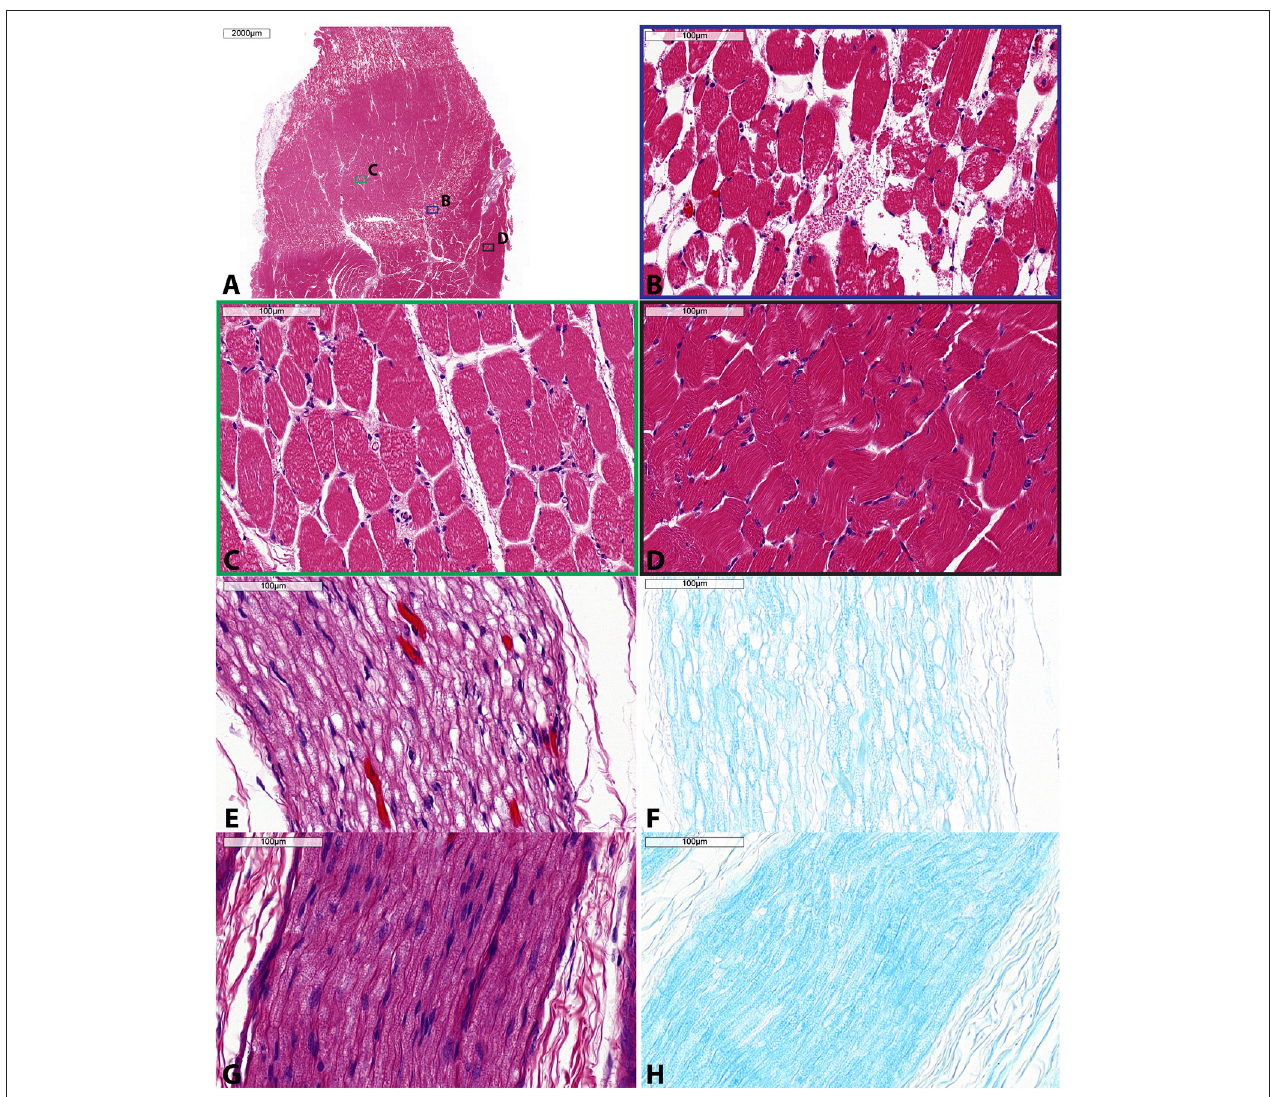
FIGURE 6 | Histologic specimens taken of muscle (A–D) and sciatic nerve (E–H) following single sonication MRgFUS treatment. (A) Low magnification showing zonal changes within the muscle—severe, moderate, and mild. Within this muscle specimen, colored boxes indicate areas of high magnification shown in panels (B–D) , each corresponding to these zonal changes. (B) High magnification of severe muscle involvement (blue) shows diffuse edema, myofiber vacuolation, and myofiber dropout. (C) High magnification of moderate muscle involvement (green) shows perimysial and endomysial edema, myofiber vacuolation, and myofiber necrosis. (D) High magnification of mild muscle involvement (black) shows mild myofiber atrophy and endomysial edema. (E) High magnification of involved nerve shows endoneurial edema, demyelination, and axonal fragmentation as highlighted by (F) LFB stain. (G) High magnification of control nerve H&E stain and (H) LFB stain. H&E, hematoxylin and eosin; LFB, luxol fast blue. Scale bar is 2,000 µ m in (A) and 100 µ m for (B–H)